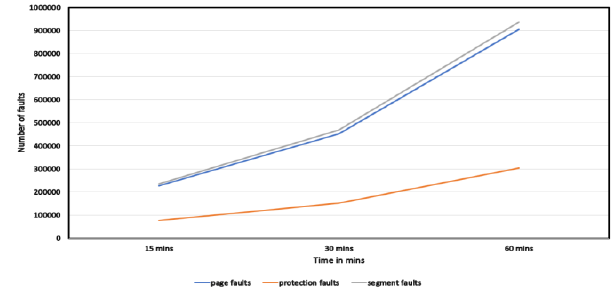
Figure 6. Number of checkout requests against